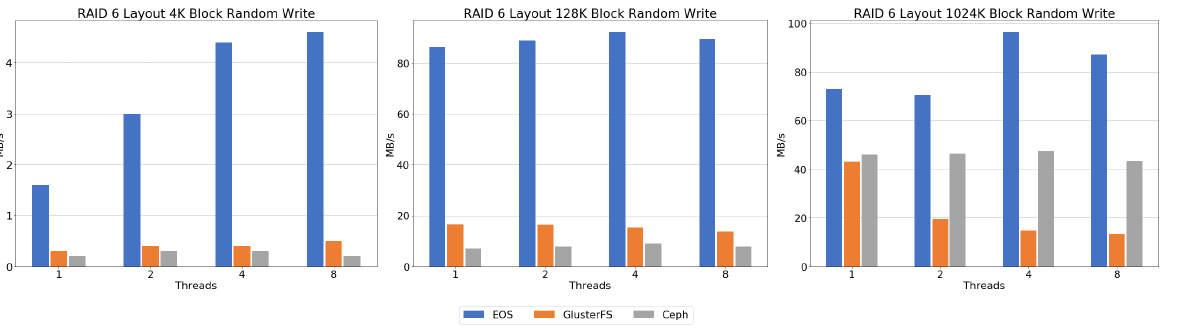
Figure 17. RAID 6-like layout—random write